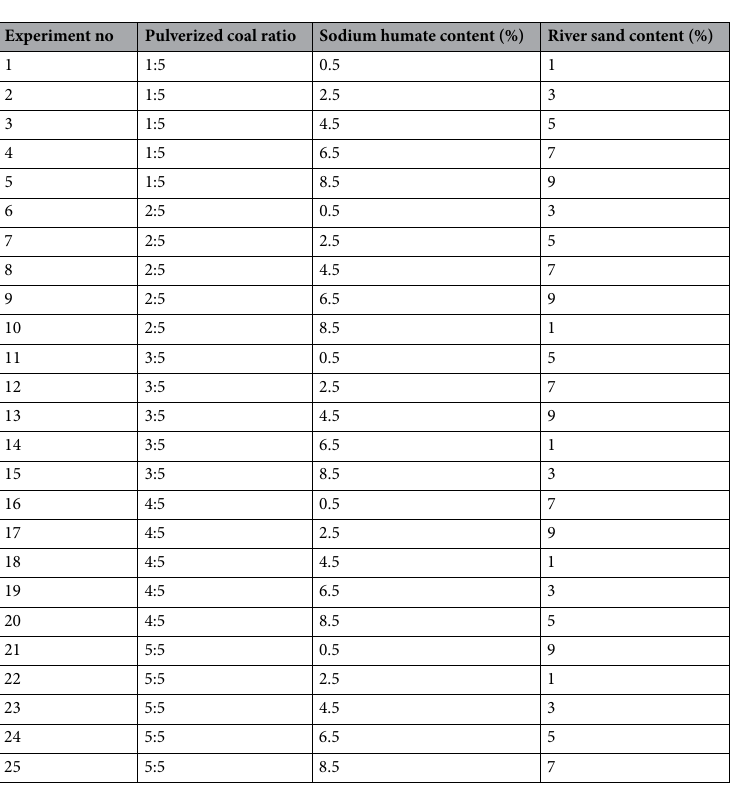
Table 3. Ratio table of physical and mechanics parameters for similar materials of L25 (5 6